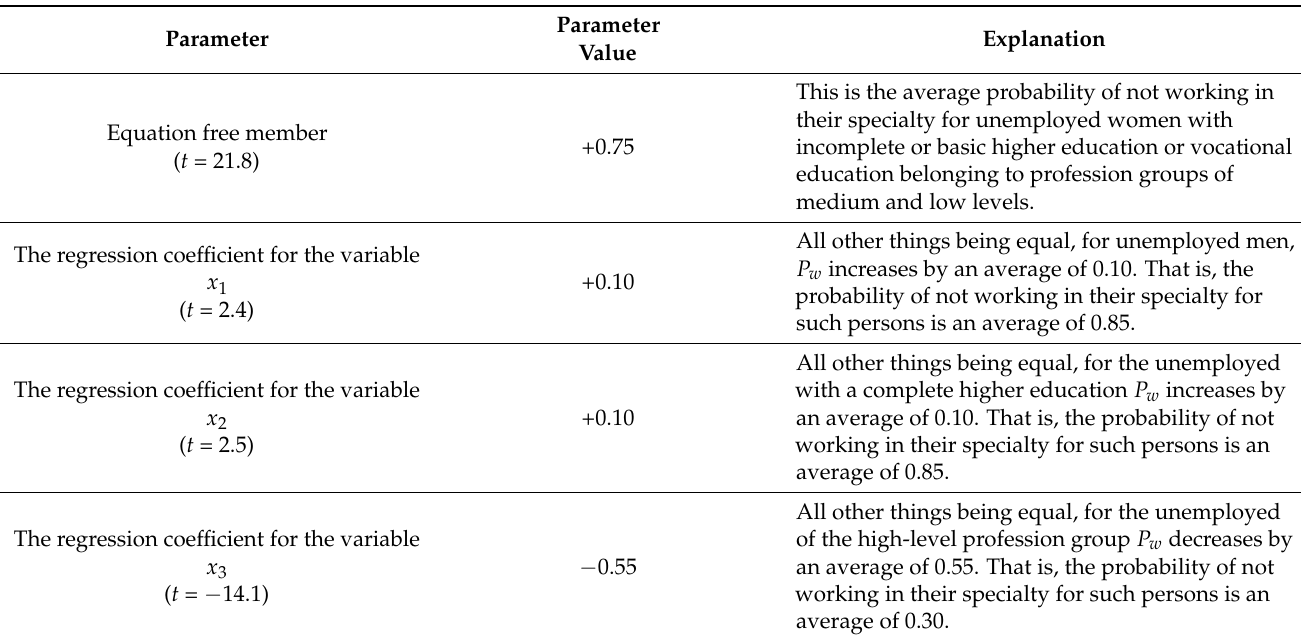
Table 1. Interpretation of model parameter values (author’s calculations).